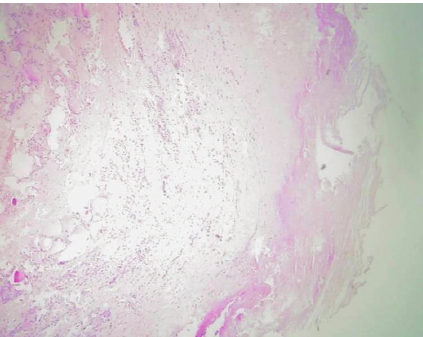
Figure 3: Histopathologic examination of the removed thyroid and cyst. A dense hyalinized fibrous tissue and a mixed inflammatory infiltrate (including eosinophils) were present between the cyst and thyroid tissue. HE ×